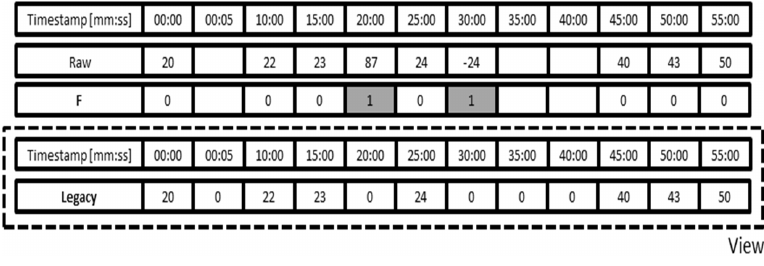
Figure 4. A view on the data for legacy system setting all faulty and missing data to zero.